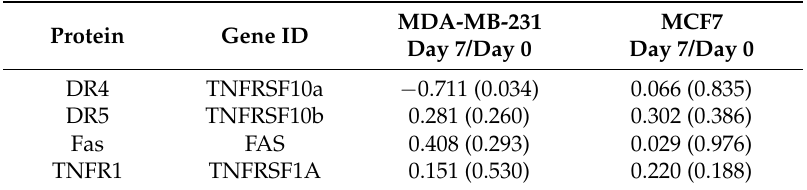
Table 1. Relative gene expression (log 2 ratio (day 7 suspension/monolayer culture) of the DR4, DR5, Fas, and TNFR1, determined by the Phalanx Biotech Human OneArray DNA microarray (data shown as log 2 ratio ( p -value)).